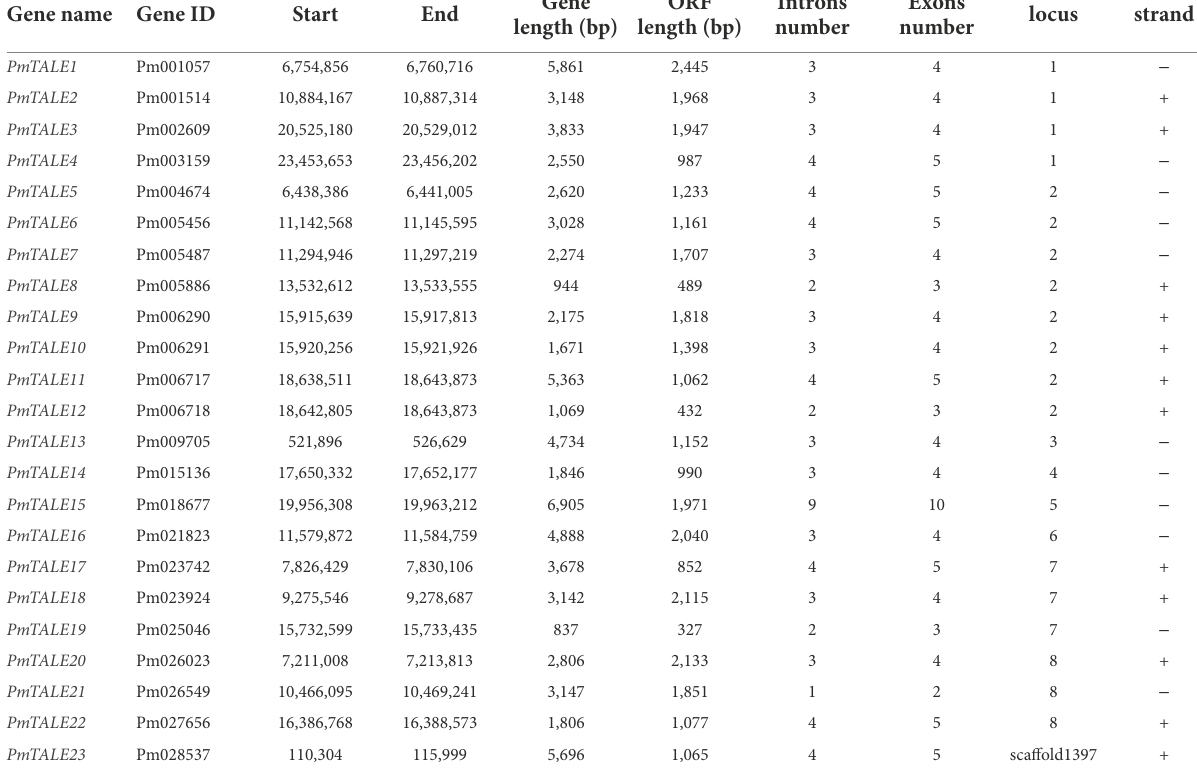
TABLE 1 Basic information of Prunus mume TALE gene family members. Gene name Gene